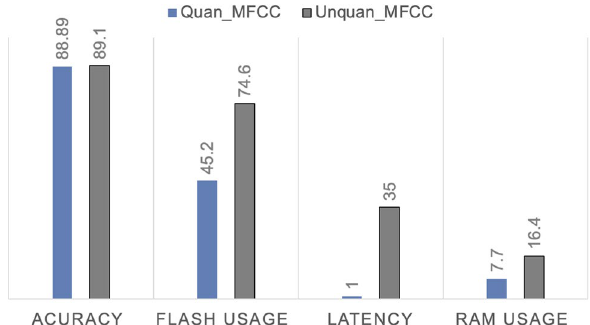
Fig. 8 The effect of quan- tization on CNN model’s performance